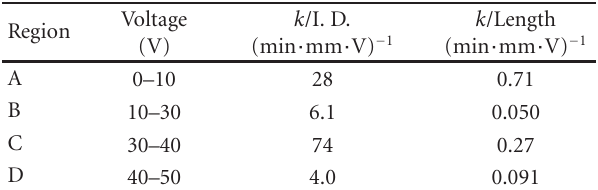
Table 1: The dependence of rate constant on the inner diameter (I. D.) and the length of titania nanotube